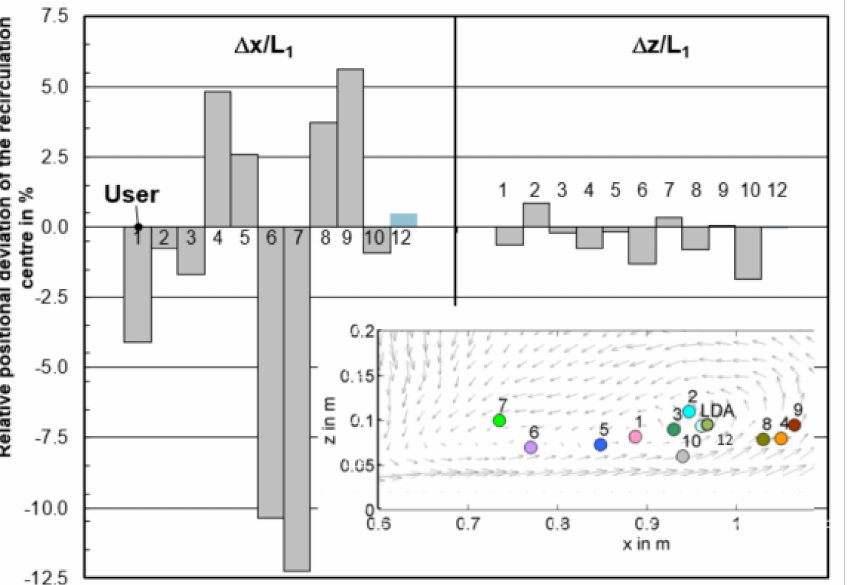
Figure 14. Relative positional deviation ∆ x/L 1 and ∆ z/L 1 of the recirculation center from CFD models among users (y/L 1 = 0).